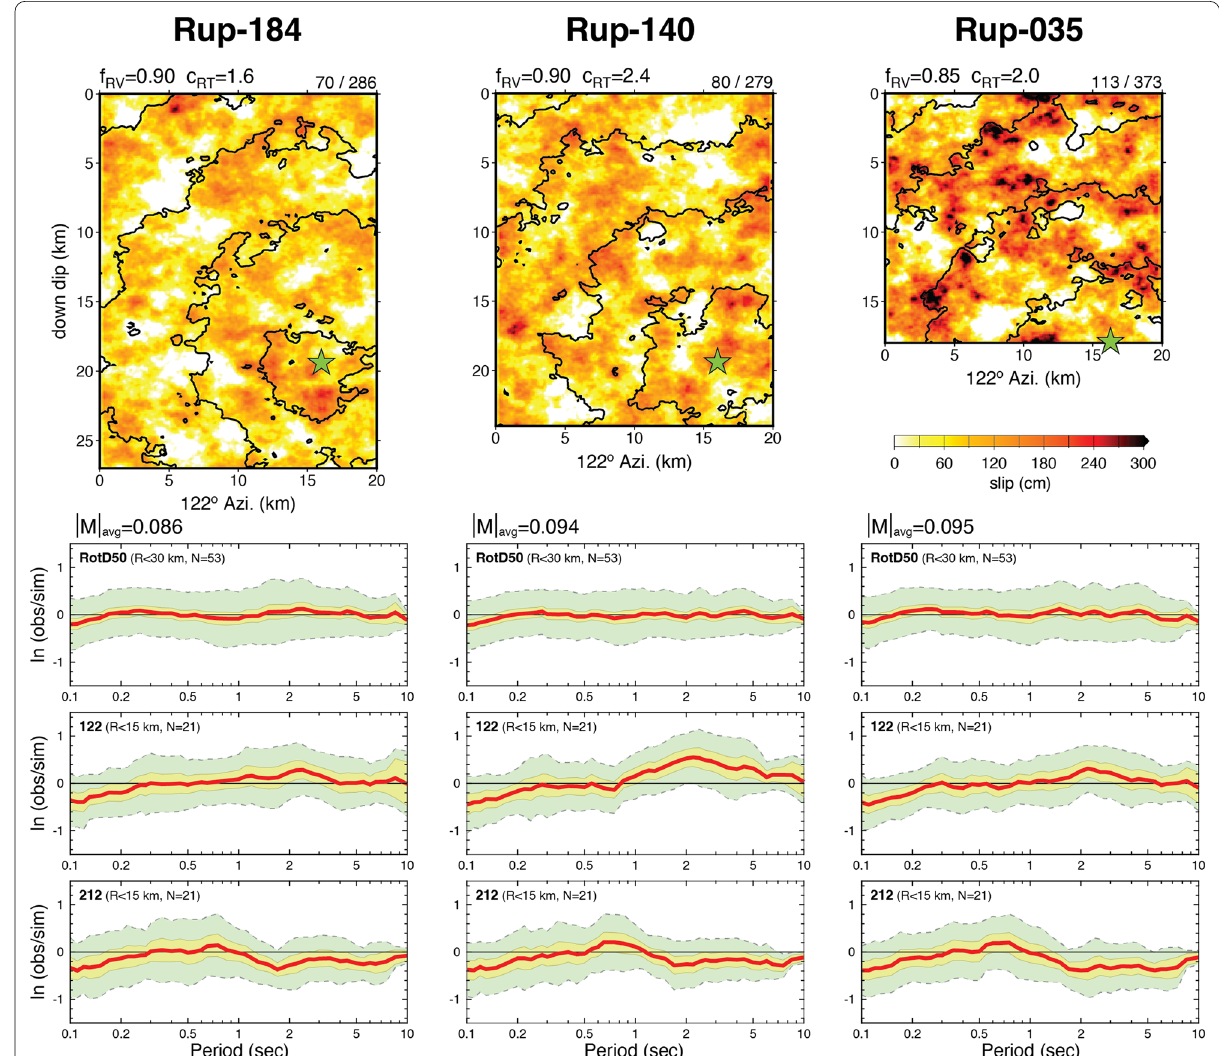
Fig. 7 Top panels show rupture models for the three realizations with the lowest | M | avg for the Northridge simulations. The labels at the top left of each rupture indicate the f RV and c RT corresponding to the particular realization and numbers at the top right indicate the average and maximum slip, respectively. Below each rupture are the corresponding GoF results in the period range 0.1 to 10 s for the RotD50, FP (122°) and FN (212°) components, respectively. The red line is the bias (Eq. 4), the green region is the standard deviation (Eq. 5) and the yellow region is the 95% confidence interval of the mean. The | M | avg value for each realization is given at the upper left of the RotD50 GoF